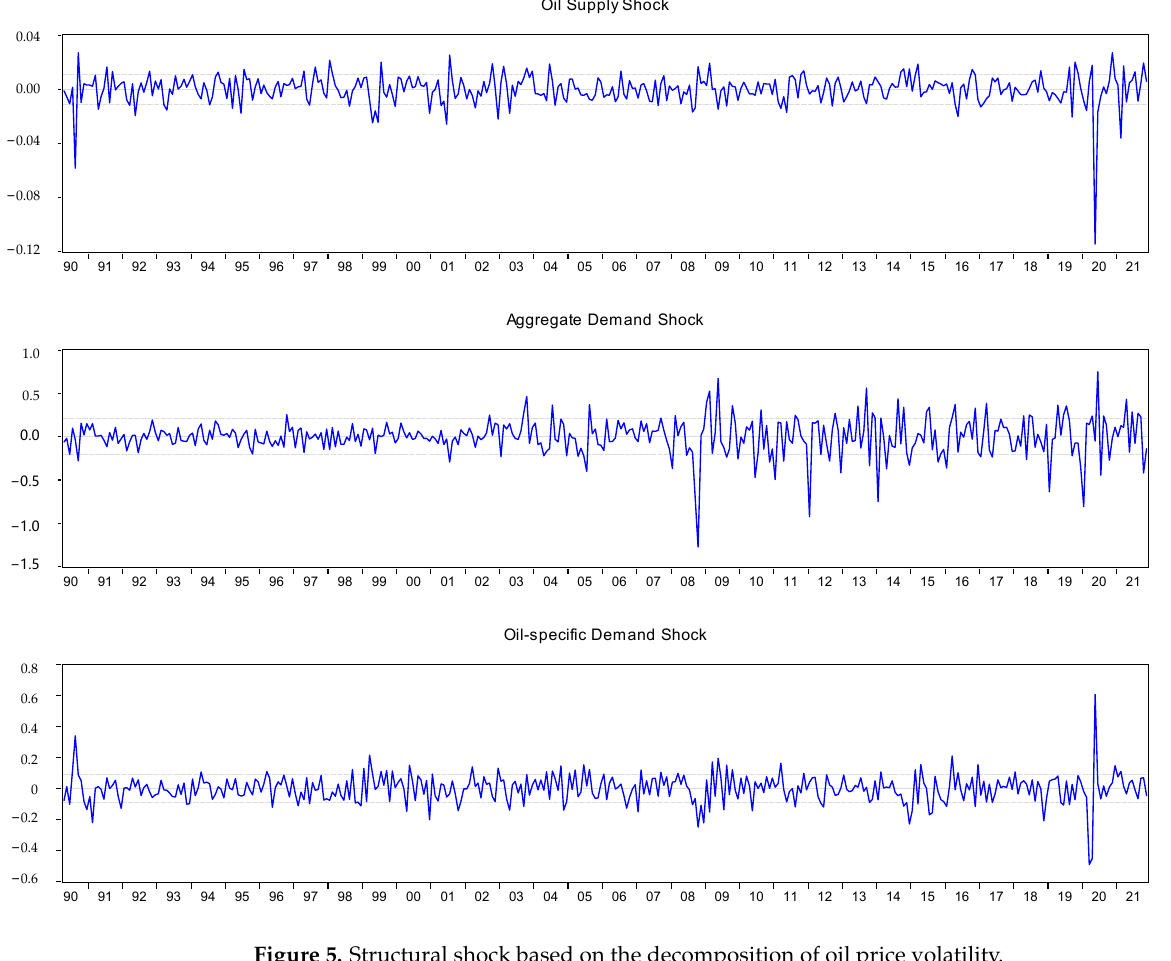
Figure 5. Structural shock based on the decomposition of oil price volatility. Table 5. Variance decomposition result of oil price volatility